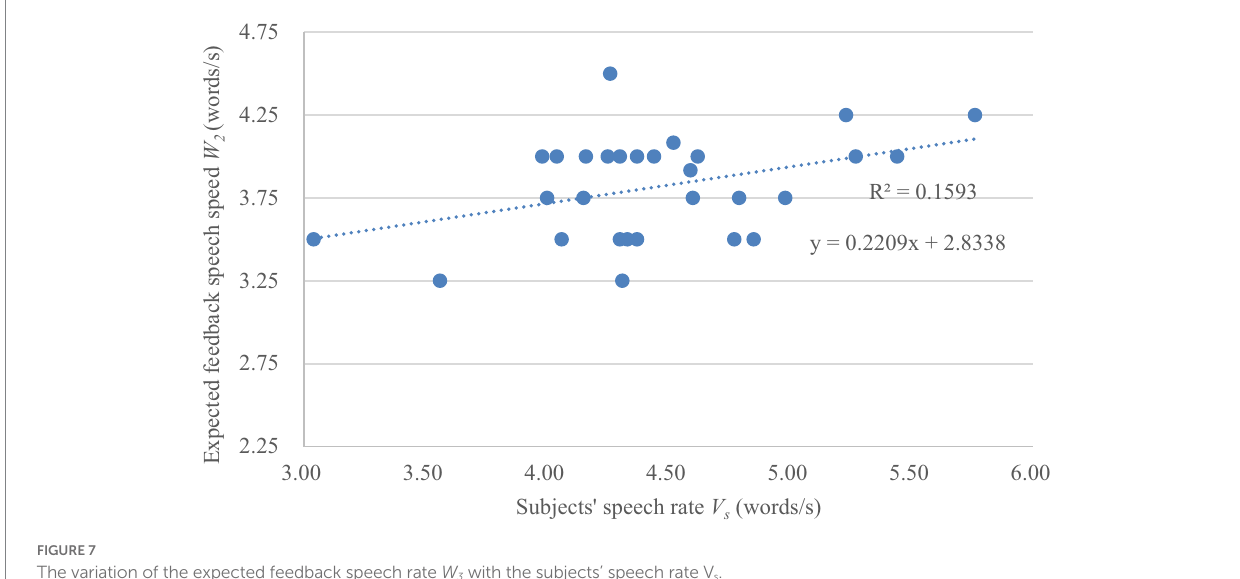
FIGURE 7 The variation of the expected feedback speech rate W 3 with the subjects’ speech rate V s .